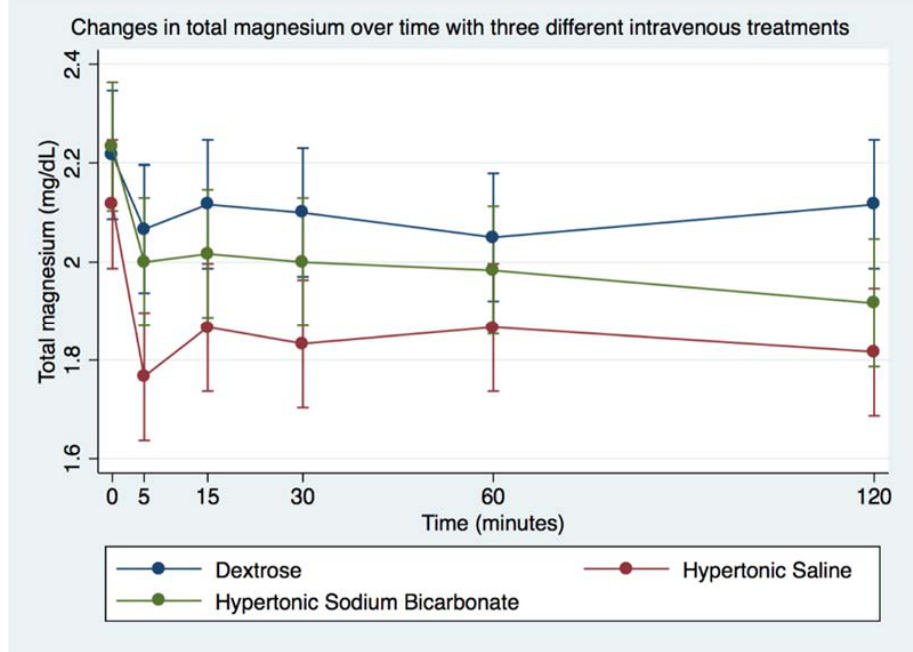
Figure 7. Overall effect of treatment on the blood total magnesium (tMg) over time. The mean and SEM venous blood tMg for all six horses. Blue = Treatment Group DS (5% dextrose solution at 2 mL/kg bwt); Green = Treatment Group HB (NaHCO 3 8.4% solution at 2 mmol/kg bwt); and Red = Treatment Group HS (NaCl 7.5% solution at 4 mL/kg bwt).